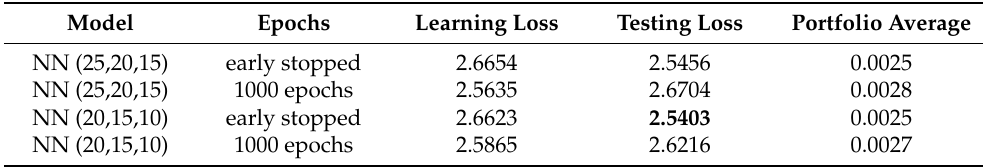
Table 6. The testing loss, learning loss, and portfolio average of the Poisson neural network models ((20,15,10), and (25,20,15) architectures) with and without early stopping.